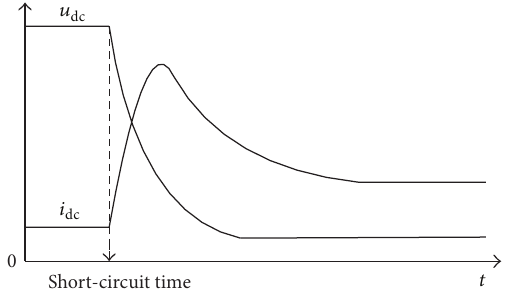
Figure 7: The schematic waveforms of DC voltage and current during